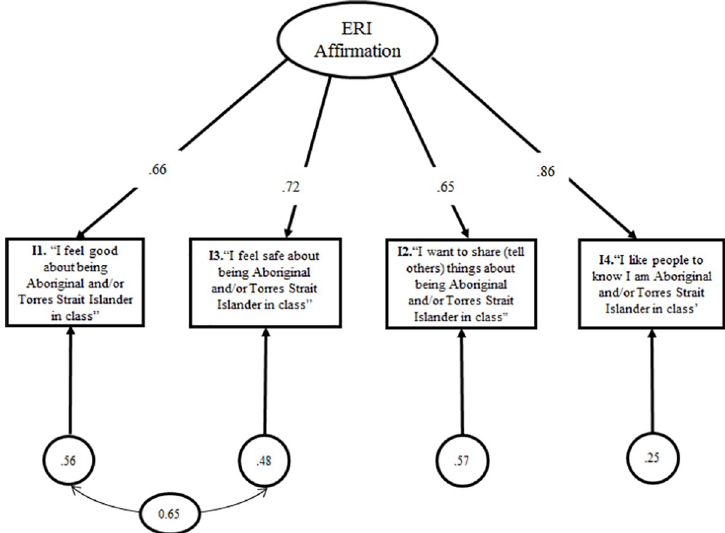
Fig 1. Unidmensional structural model of ethnic-racial identity affirmation accouting for correlated uniqueness.